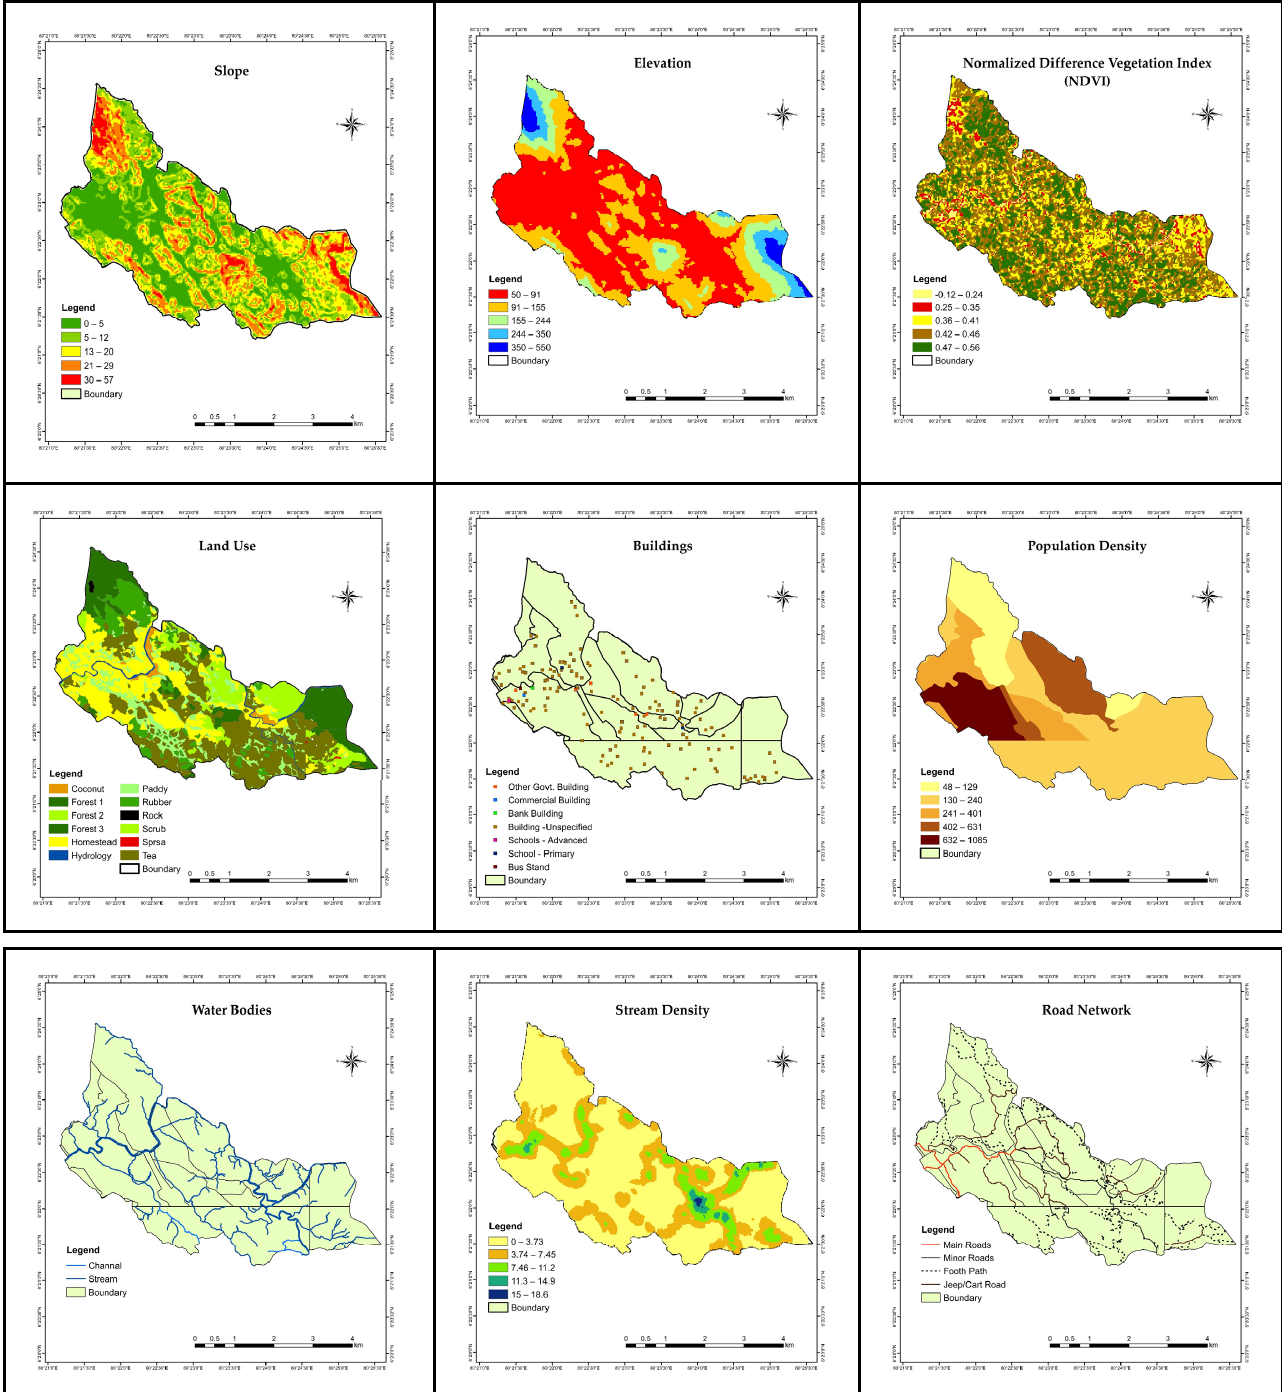
Figure 2. Sub-criterion maps used for the study.